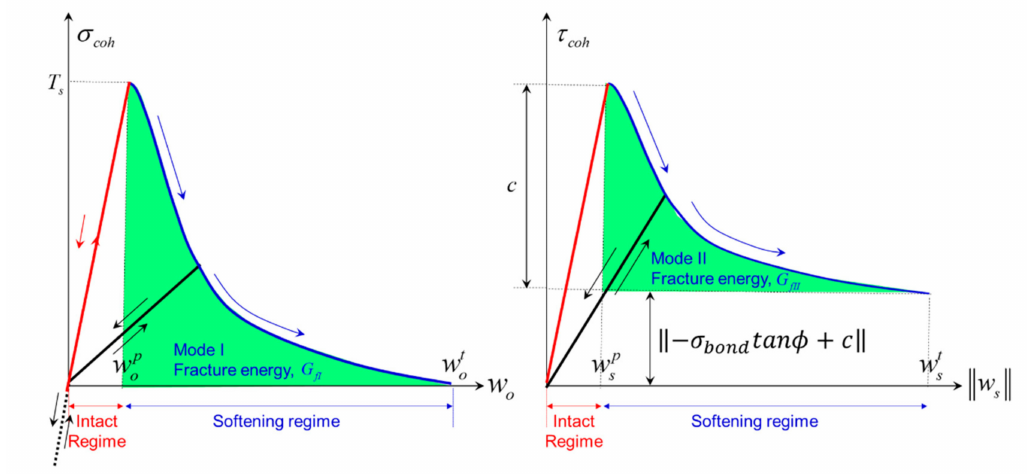
Figure 3. Tensile ( left ) and shear ( right ) softening curves in the